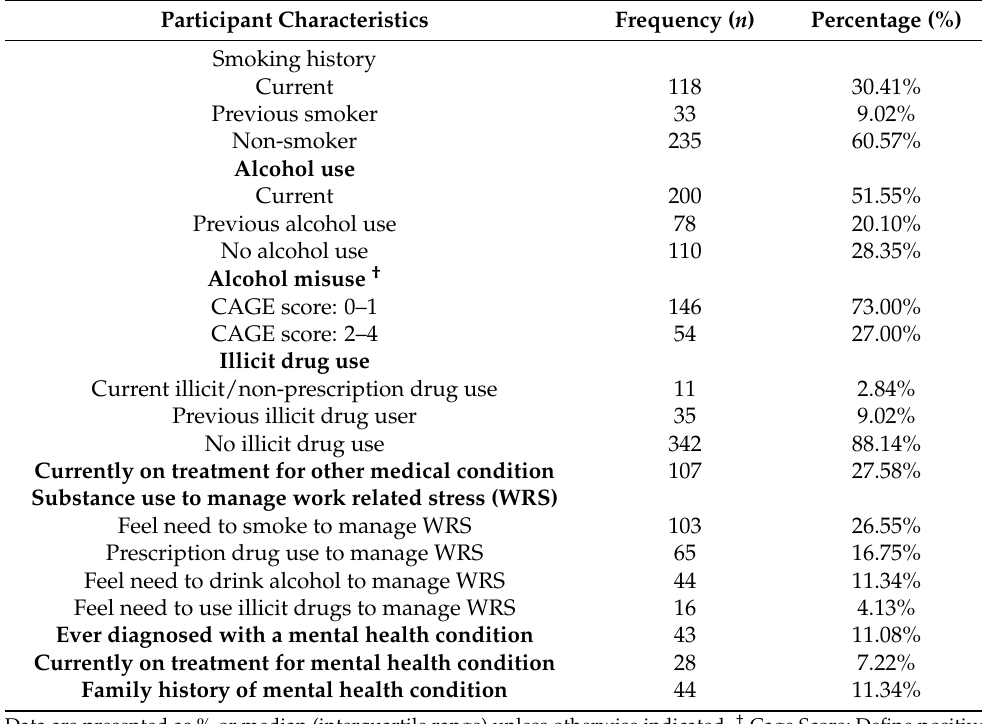
Table 2. Frequency and distribution of general health specific variables ( n =